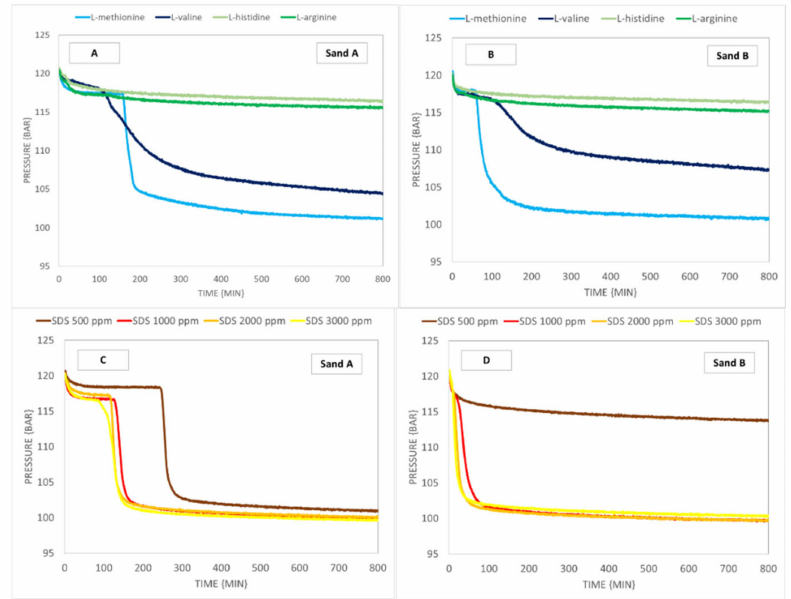
Figure 6. Pressure profiles of CO 2 -rich gas hydrate formation using 20 mol% CO 2 during isothermal experiments at 120 bar initial pressure and 1 ◦ C for four amino acids (3000 ppm) and SDS (500, 1000, 2000, and 3000 ppm) during CGHF with varying sand types (A and B) and Gas A. ( A ) Sand A with amino acids, ( B ) Sand B with amino acids, ( C ) Sand A with SDS, and ( D ) Sand B with